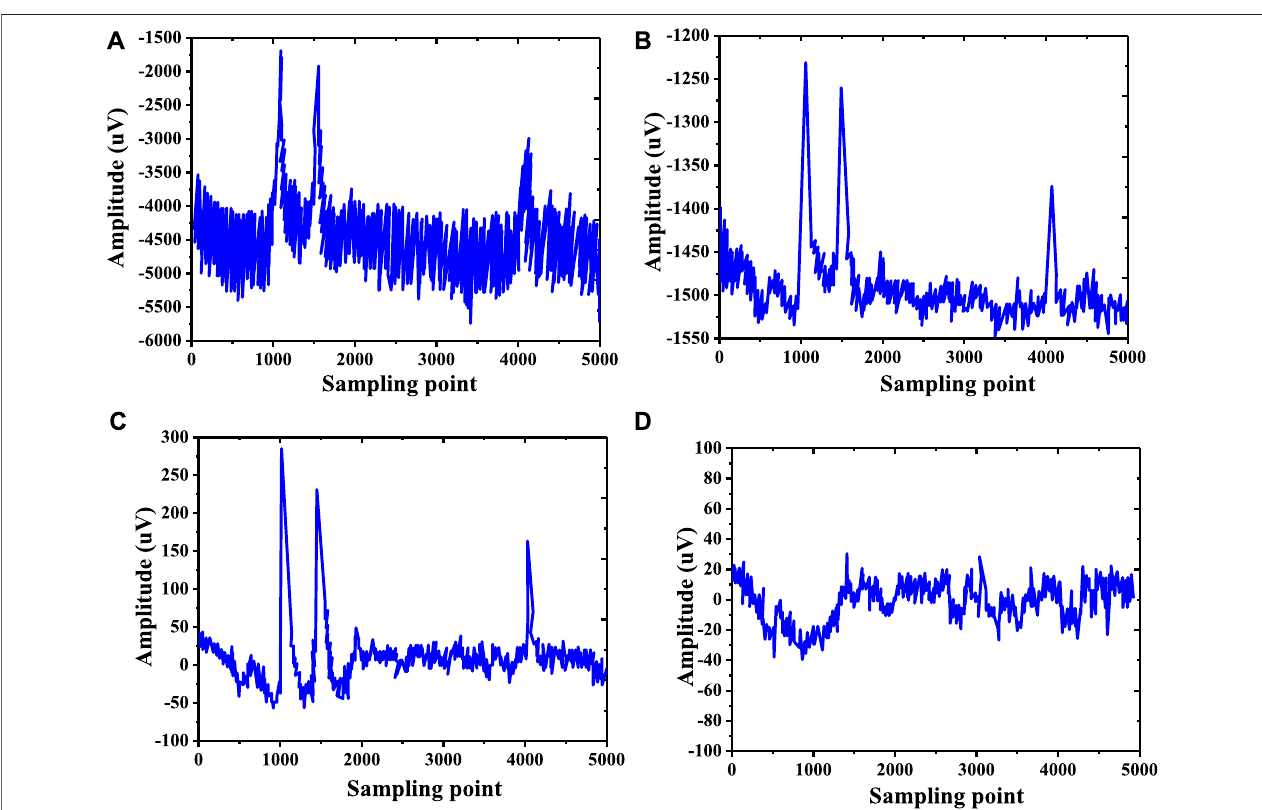
FIGURE 9 | FAW-FS algorithm EEG de-noising results. [Note: (A) : Original EEG image; (B) : EEG image after down-sampling processing; (C) : EEG image after band-pass fi lter; (D) : EEG image of FAW-FS algorithm feature extraction].